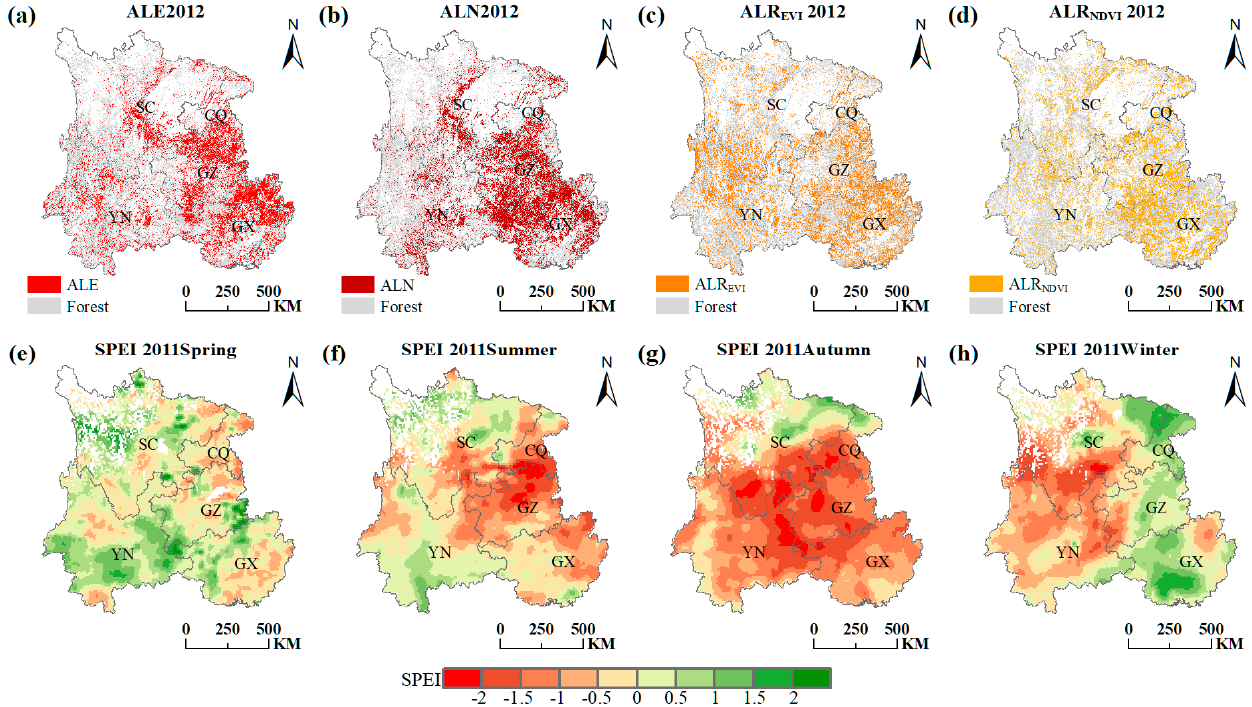
Figure 6. Spatial pattern of the ALE in 2012 ( a ), ALN in 2012 ( b ), ALR EVI in 2012 ( c ), ALR NDVI in 2012 ( d ), the 2011 spring drought ( e ), the 2011 summer drought ( f ), the 2011 autumn drought ( g ) and the 2011 winter drought ( h ) across Southwest China. The abbreviation: CQ (Chongqing), SC (Sichuan), GZ (Guizhou), YN (Yunnan) and GX (Guangxi).